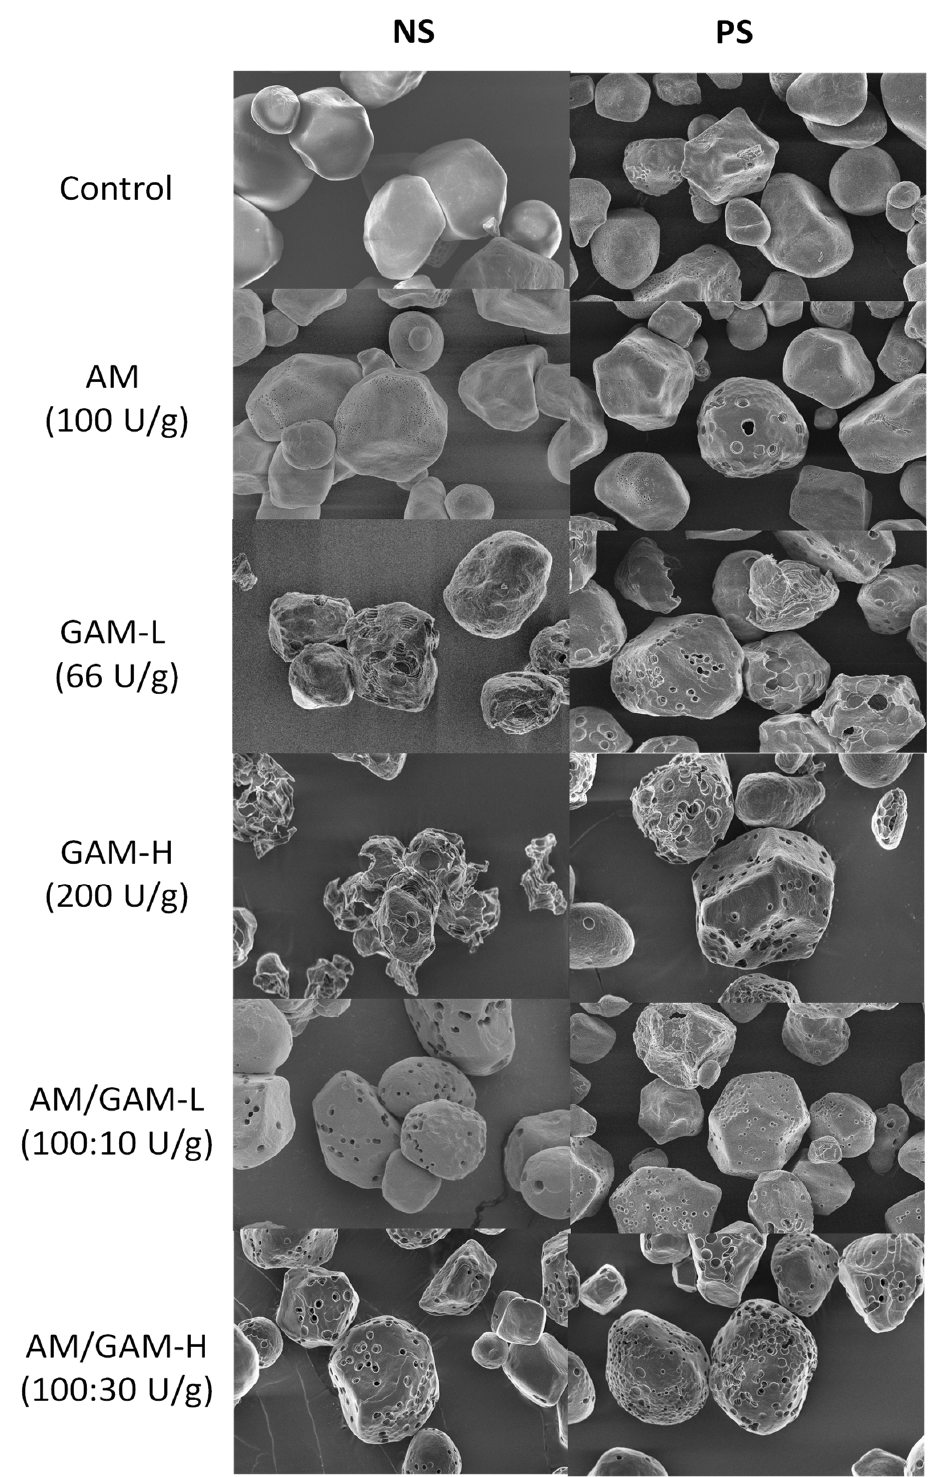
Figure 1. Scanning electron microscopy (SEM) micrographs of native starch (NS) and pretreated starch (PS) with their respective enzymatic treatment: α -amylase (AM), glucoamylase (GAM) and a mixture of both enzymes with two concentrations of GAM (AM/GAM-L and AM/GAM-H). Magnification scale: 2000×.